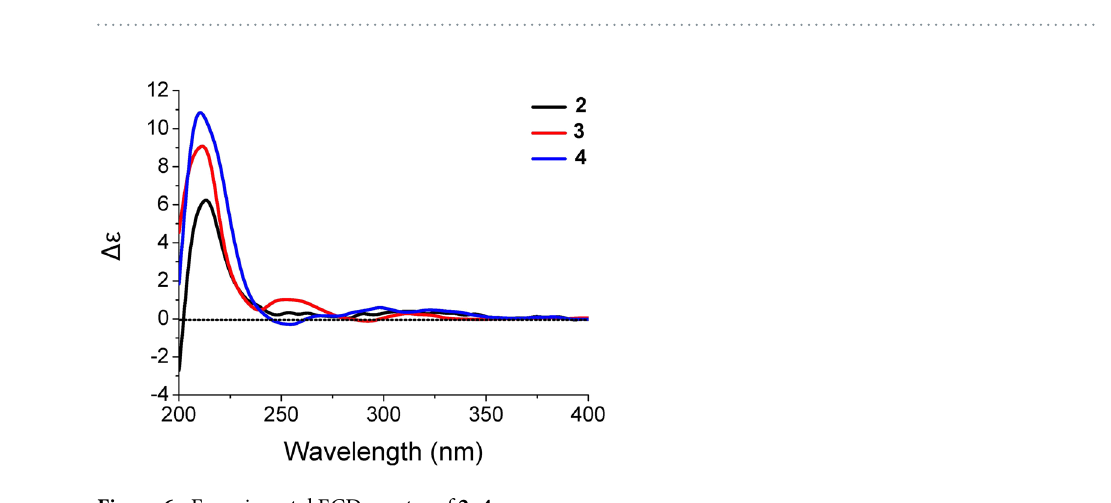
Figure 5. Comparison of the experimental ECD spectra of 1 and avarol to the calculated ECD spectra of 1 and its enantiomer.